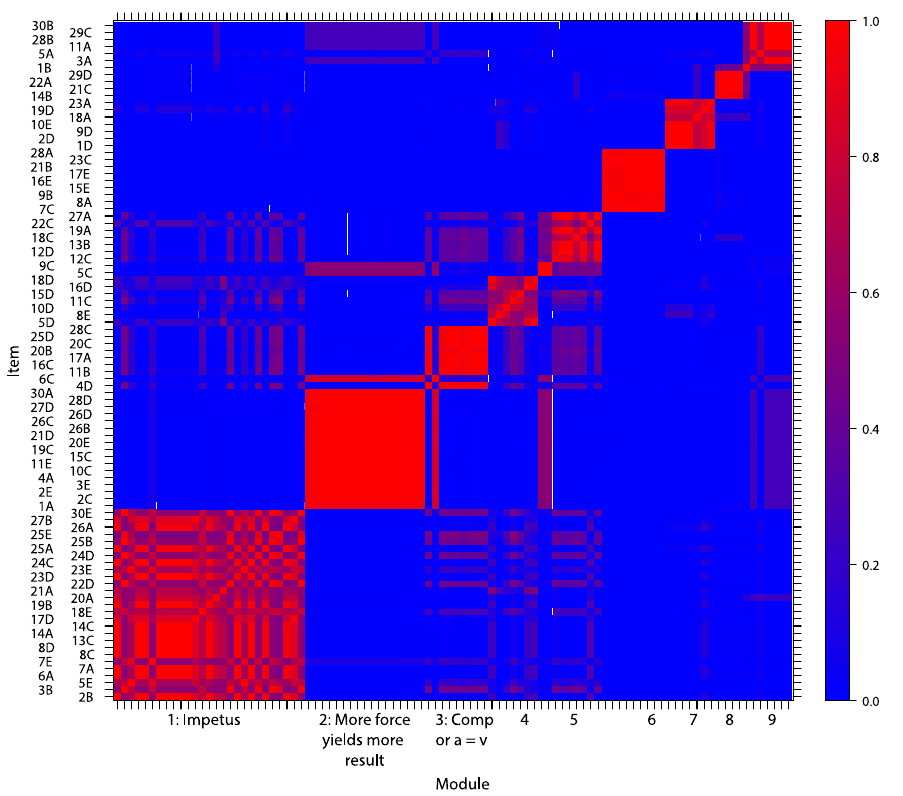
FIG. 8. Module co-occurrence matrix comparing module pairs found by 1000 iterations of InfoMap with the modules we use here. The color indicates the fraction of times two items have been grouped together, ranging from 0 (blue) to 1 (red). Note that modules 3 – 5 might be interpreted as one big module or as 3 separate